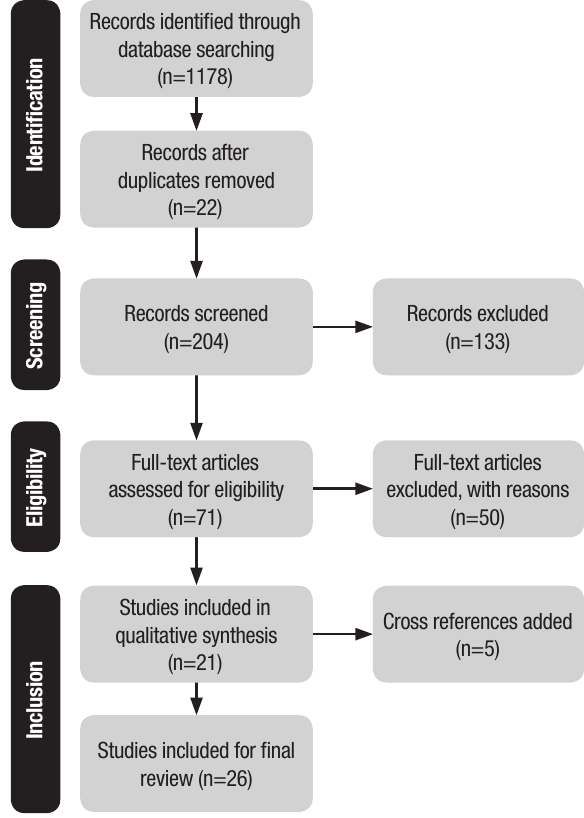
Figure 1. Summary of the study search and selection procedure. São Carlos,